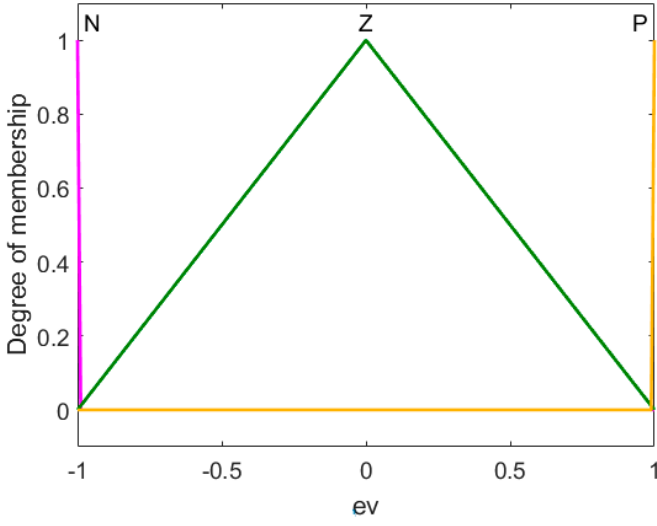
Figure 5. Input linear velocity (ev), not optimized.